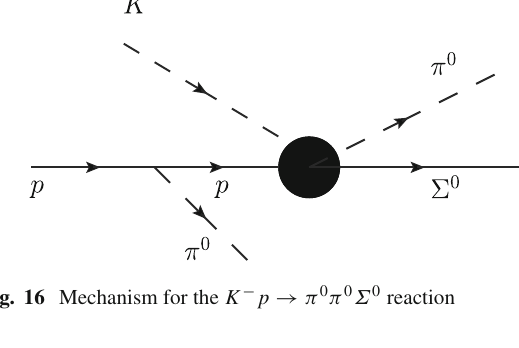
Fig. 16 Mechanism for the K − p → π 0 π 0 Σ 0 reaction